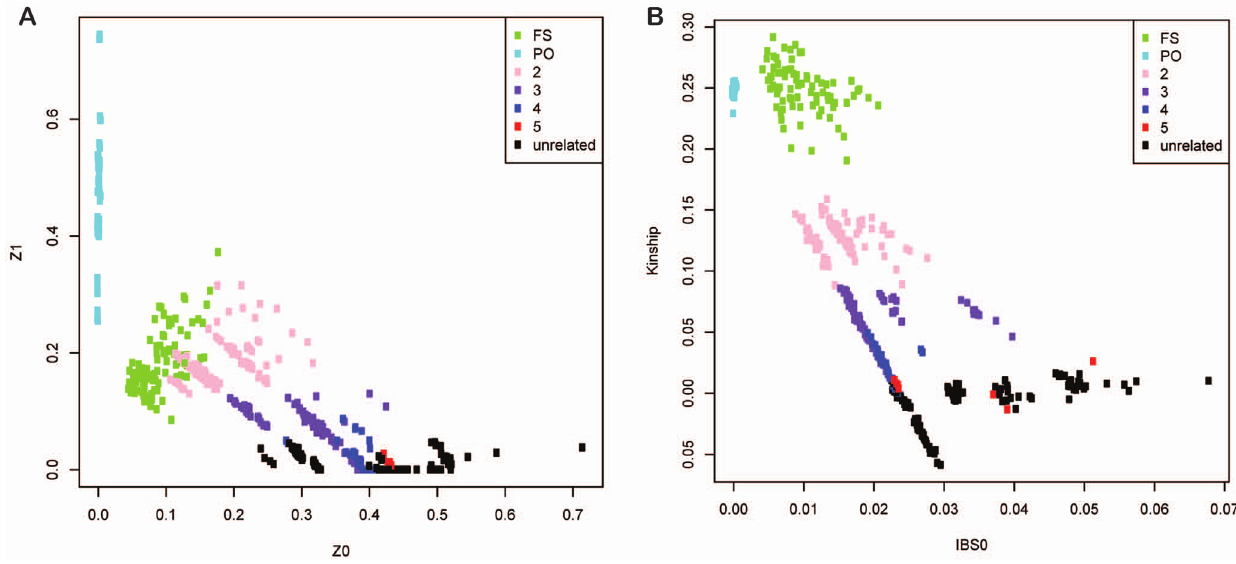
Figure 4. Performance of (A) PLINK and (B) KING on true families. Reported relationships are illustrated by different colors. PLINK’s output Z0 P(IBD=0) and Z1 P(IBD=1) are plotted, KING’s output IBS0 (proportion of zero IBS) and kinship coefficient are plotted. Relationship must be estimated by visualization of the clusters in the graph.